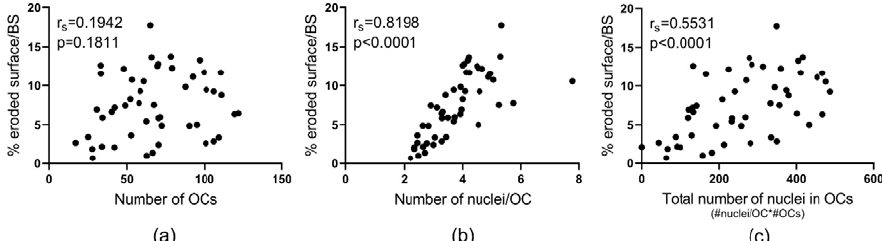
Figure 4. Fusion potential of OCs determines their bone resorptive activity in vitro. The relation between the percent eroded surface per bone surface in vitro and ( a ) the mean number of OCs (per vision field), ( b ) the mean number of nuclei per OC (reproduced from: Møller et al. 2020 [17] with permission of Bone Research published by Springer Nature, 2020), and ( c ) the total number of nuclei in OCs (per vision field). Of note, the numbers of OCs and nuclei were all assessed before the matured OCs were reseeded onto bone slices. Statistics: correlation analyses were performed using Spearman’s rank correlation (r s ). Each point represents the results obtained from OCs in vitro generated from an individual donor ( n = 49). “#”, number; “*”, multiplied by.